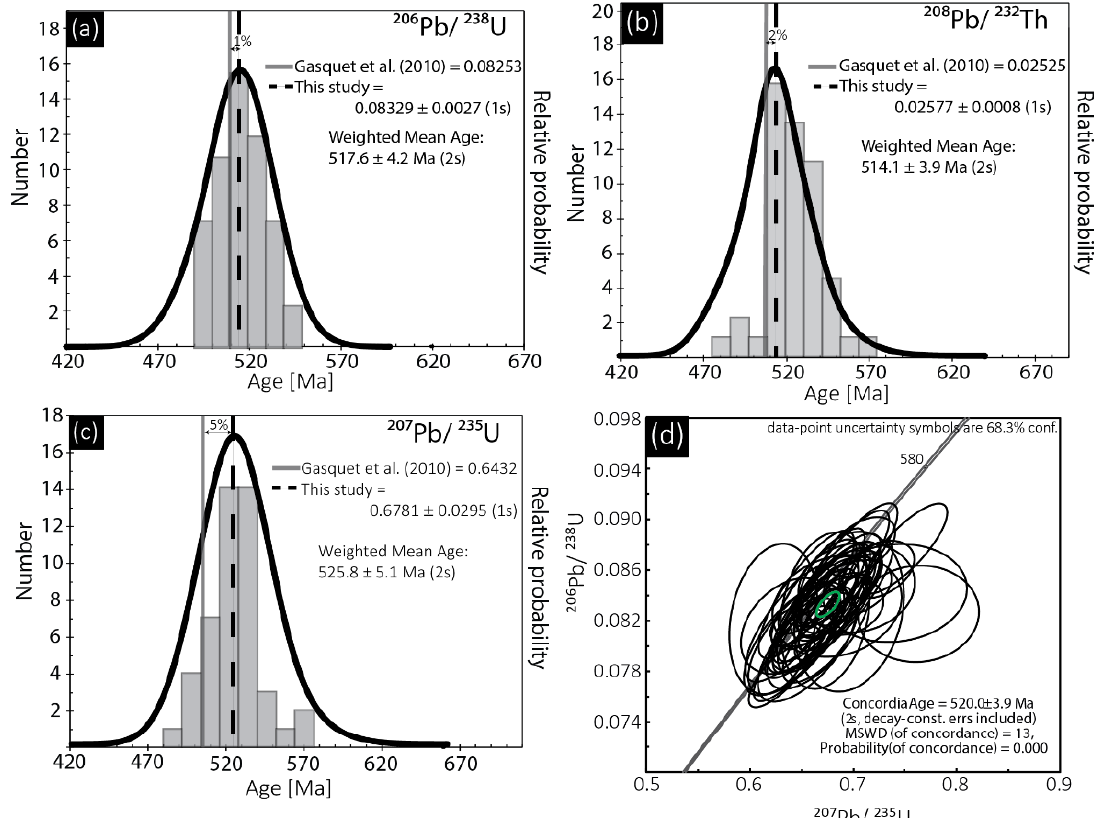
Figure 7. Relative probability plots [using Isoplot add-in for Excel, 64]) for ( a ) 206 Pb / 238 U (n = 54), ( b ) 208 Pb / 232 Th (n = 51) and ( c ) 207 Pb / 235 U (n = 46) ages of all analytical sessions from this study using a spot size of 10 µ m and a repetition rate of 10 Hz compared to published U-Th / Pb ages of [31]. For each plot the ratios and weighted mean age are given. [31] published a 206 Pb / 238 U age of 511.2 ± 0.4 Ma, which corresponds to a ratio of 0.08253 and a 208 Pb / 232 Th age of 504 Ma corresponding to a ratio of 0.02525. The 207 Pb / 206 Pb (0.056824 ± 0.072%), 207 Pb / 235 U (0.64831 ± 0.13%) and 206 Pb / 238 U (0.082830 ± 0.064%) of [21] are within analytical uncertainty. Graph ( d ) shows the concordia plot with the suggested age of